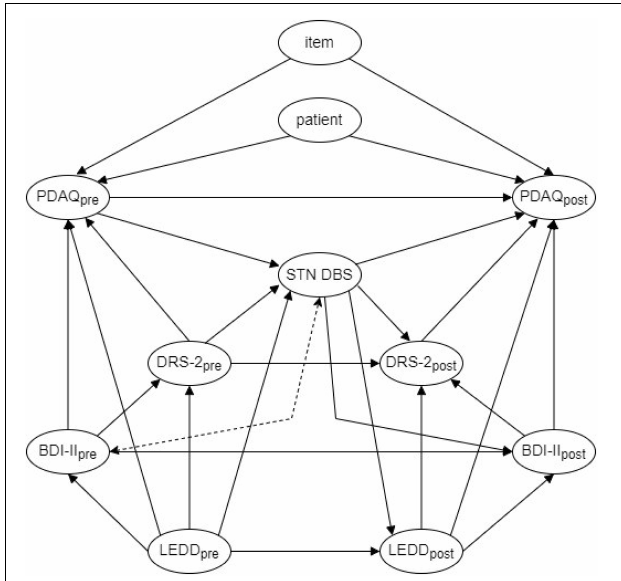
FIGURE 1 | A directed acyclic graph representing causal assumptions of the relationships between included variables. STN DBS, subthalamic nucleus deep brain stimulation; BDI-II, Beck Depression Inventory before DBS treatment (BDI-II pre ) and after DBS treatment (BDI-II post ); DRS-2, Dementia Rating Scale, second edition before DBS treatment (DRS-2 pre ) and after DBS treatment (DRS-2 post ); LEDD, levodopa equivalent daily dose before DBS treatment (LEDD pre ) and after DBS treatment (LEDD post ); PDAQ, The Penn Parkinson’s Daily Activities Questionnaire before DBS treatment (PDAQ pre ) and after DBS treatment (PDAQ post ). STN DBS was considered to be adjusted for in each of our analyses due to the lack of a control group. Dashed double arrow between BDI-II pre and STN DBS indicates a common cause assumption—this is because even though BDI-II is not used directly to decide whether patients receive STN DBS in our center, patients with clinical depression according to an independent psychiatric evaluation are both rejected to STN DBS and at risk of high BDI-II.